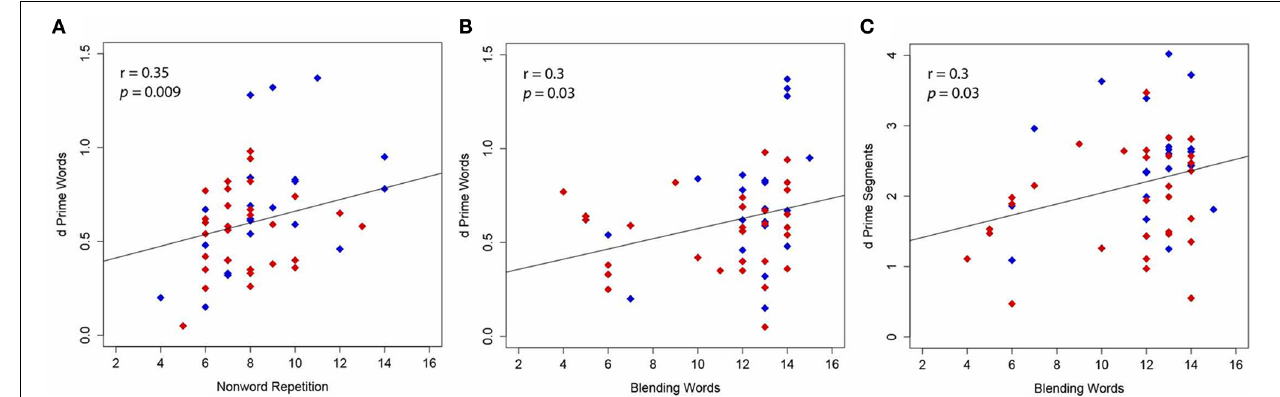
FIGURE 1 | Blue indicates good readers. Red indicates poor-to-dyslexic readers. Correlations show the relationship between phonemic restoration and subtests of the Comprehensive Test of Phonological Processing (CTOPP). A high d (cid:2) score (y-axis) indicates that the critical segments are not perceived as alike and restoration does not occur. As such, the positive